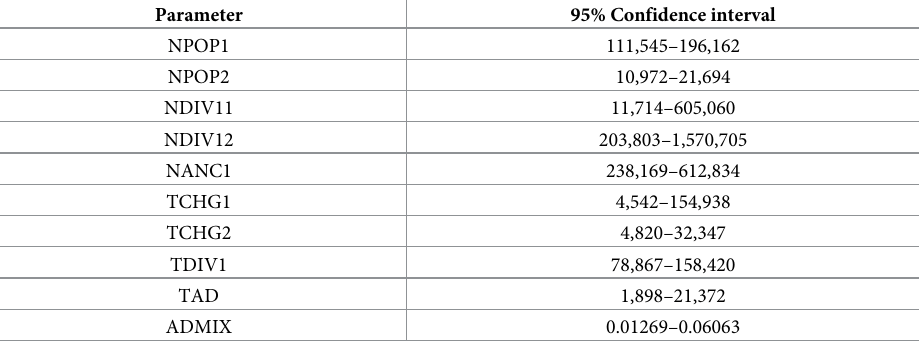
Table 2. Confidence intervals for each parameter in the best model